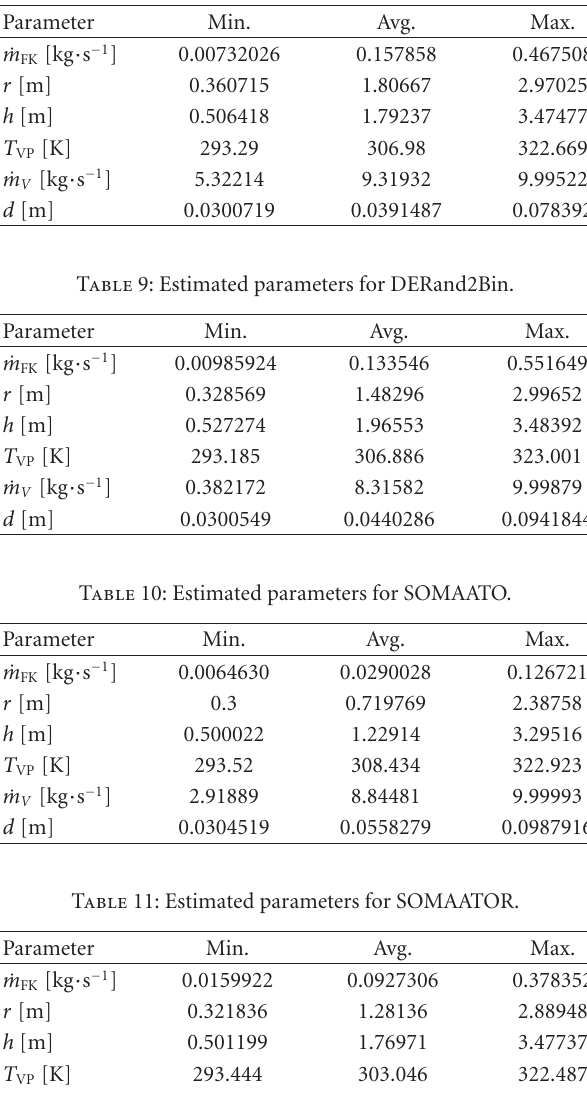
Table 3: GA parameter setting.